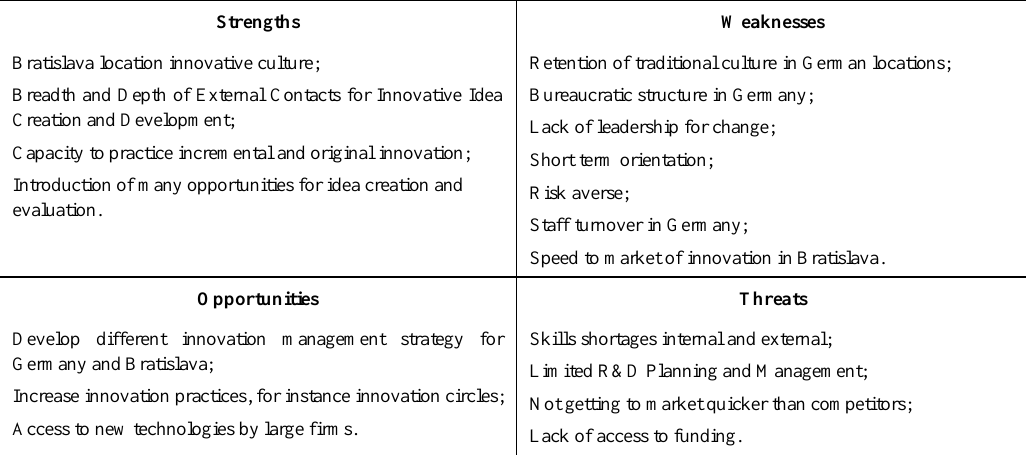
Table 5. Internal Strengths and Weaknesses & External Opportunities and